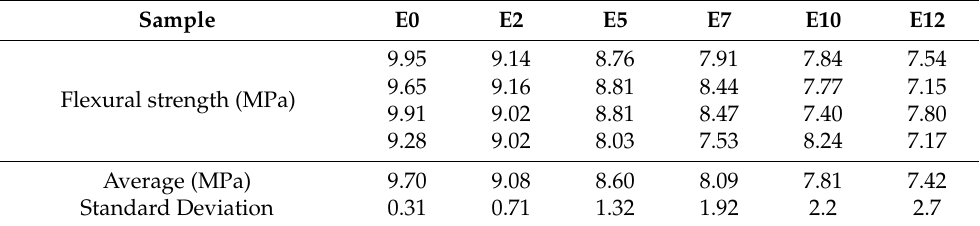
Table 5. Average results of flexural strength (MPa).